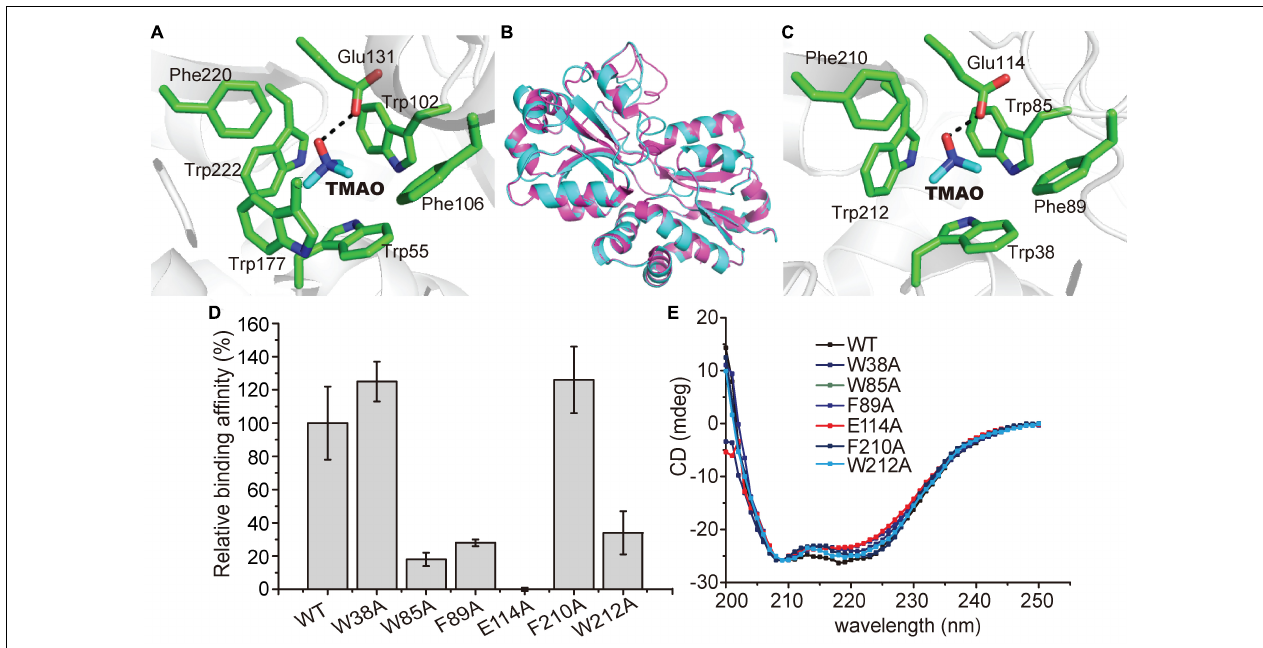
FIGURE 6 | Possible residues involved in the binding of TMAO in TmoX 1062 . (A) Residues composing the TMAO binding pocket in TmoX DSS − 3 (PDB code: 4XZ6). The TMAO molecule is colored in blue, and TmoX DSS − 3 residues are colored in green. The possible hydrogen bond is represented by the dashed line. (B) Superimposed structures of TmoX DSS − 3 (purple) and TmoX 1062 (cyan). (C) Residues composing the TMAO binding pocket based on modeling structure of TmoX 1062 . The TMAO molecule is colored in blue, and TmoX 1062 residues are colored in green. The possible hydrogen bond is represented by the dashed line. (D) Binding affinities of WT TmoX 1062 and its mutants toward TMAO. The binding affinity of WT TmoX 1062 was defined as 100%. The error bar represents standard deviation of triplicate experiments. (E) CD spectra of WT TmoX 1062 and its mutants.